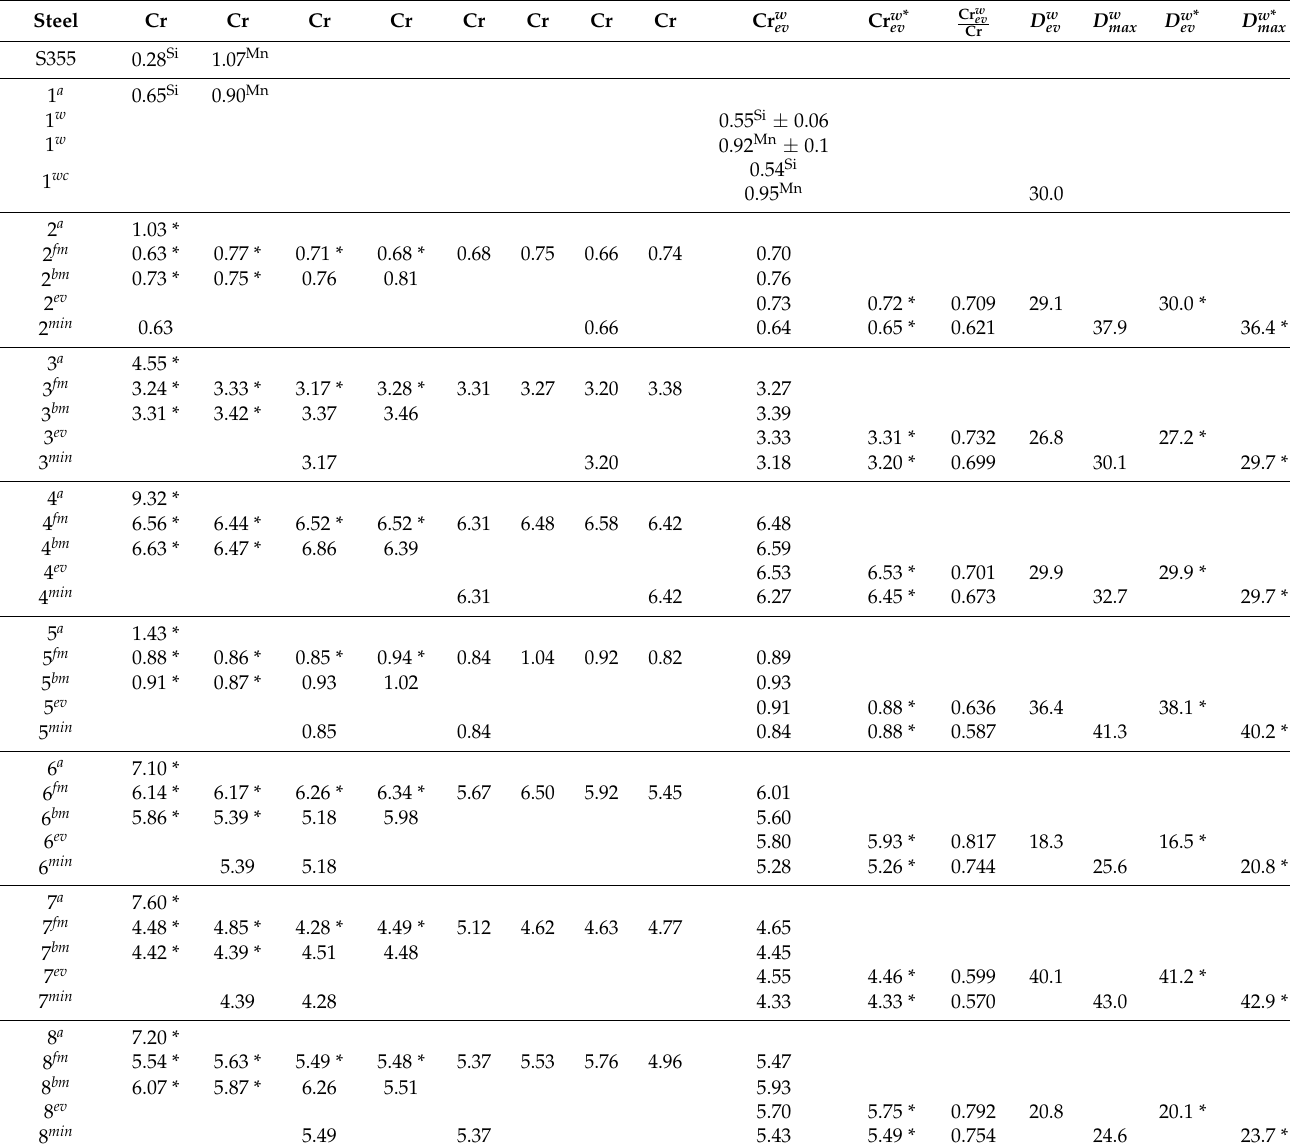
Table 1. Contents of the alloying elements Cr, Si, and Mn (wt.%) in the materials and admixing rates D (%) of the S355 steel in the individual single-bead surface